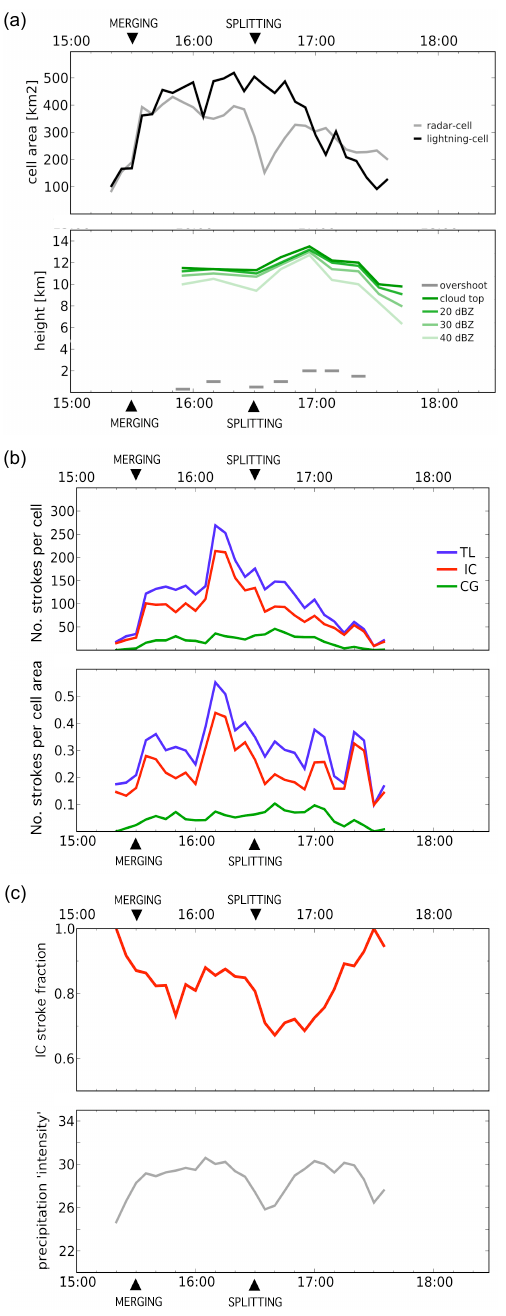
Fig. 9. Lifetime diagrams of selected cell parameters for the thun- derstorm case study from 25 June 2008. (a) Radar- and lightning- cell areas (top) and iso-reflectivity heights a.g.l. (green) and over- shooting top height relative to the mean anvil top height estimated from POLDIRAD radar data (grey bars) (bottom, shared axis). (b) 3min TL stroke rates per cell (top) and per respective lightning- cell area (bottom). (c) IC fraction to TL stroke rate (top) and precip- itation “intensity” per radar-cell area as described in text